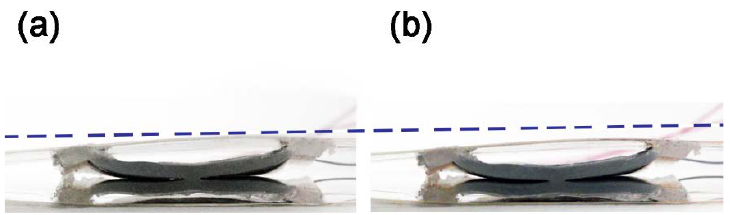
Figure 4. Motion of the X-shaped actuator: ( a ) its original shape without a voltage input, and ( b ) its contracted shape when a voltage difference is applied.